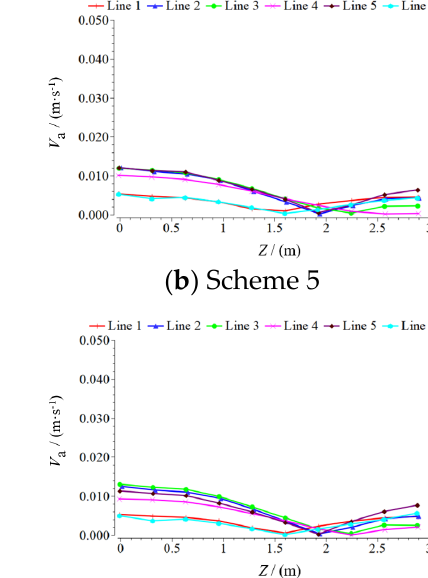
( d ) Scheme 7 Figure 20. Diagram of axial velocity before the bell mouth in the sump 4# Table 4 shows the axial velocity uniformity and axial velocity weighted average angle of Section 5 in the sump for each scheme. As shown in the table, the axial velocity uni- formity of the original scheme is poor. The maximum value is 56.94% and the minimum value is just 37.9%. Compared with the original scheme, axial velocity uniformity of Sec- tion 5 for schemes 5 − 7 in the four sumps are significantly improved, with an average in- crease of 34.9%. For scheme 6, the axial velocity uniformity in sump 1# − 3# is excellent, and the smoothness of the flow in sump 4# does not change significantly. For scheme 7, the axial velocity uniformity of sump 1# − 3# is slightly improved, and the axial velocity uni- formity of sump 4# is slightly decreased. Moreover, the axial velocity weighted average angle of the original scheme is still relatively small. The maximum value is 61.17°, the minimum value is 33.49°. The axial velocity weighted average angle of schemes 5 − 7 in sump 1# − 3# is larger than 80°. The axial velocity weighted average angle of schemes 5 − 7 in sump 4# is more than 60°, which is almost two times than the original scheme. Table 4. Axial velocity uniformity and axial velocity weighted average angle of Section 5 for each scheme. Scheme